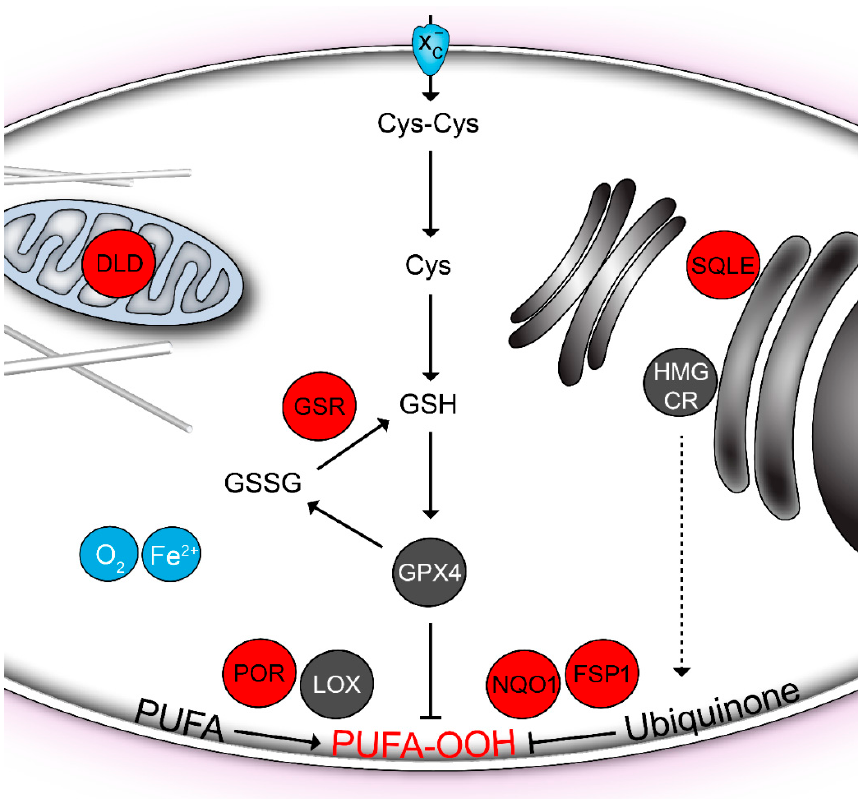
Figure 1. Ferroptosis-related flavoproteins (red). Lipid hydroperoxides (PUFA-OOH) in cellular membranes are generated during aerobic metabolism by the lipoxygenases (LOX) and cytochrome P450 oxidoreductase (POR). Molecular oxygen (O 2 ) and iron ions (Fe 2+ ) are required for lipid peroxidation. Hydroperoxides are reduced by the glutathione peroxidase GPX4 in the presence of glutathione (GSH). A precursor of glutathione, the cystine (Cys-Cys), is supplied by the transporter System x c- . Glutathione reductase (GSR) regenerates oxidized glutathione (GSSG) back to its reduced state. In addition, the endogenous lipophilic anti-oxidant ubiquinone can reduce the oxidative lipid damage. It is regenerated by the reducing enzymes NQO1 and FSP1. Ubiquinone is biosynthesized in the mevalonate pathway, which is critically controlled by the HMG-CoA reductase (HMGCR). branching point towards ubiquinone. Nevertheless, it is also involved in the ferroptosis control [16]. The mitochondrial dihydrolipoamide dehydrogenase (DLD) has been recently found to be required to induce ferroptosis upon cystine deprivation